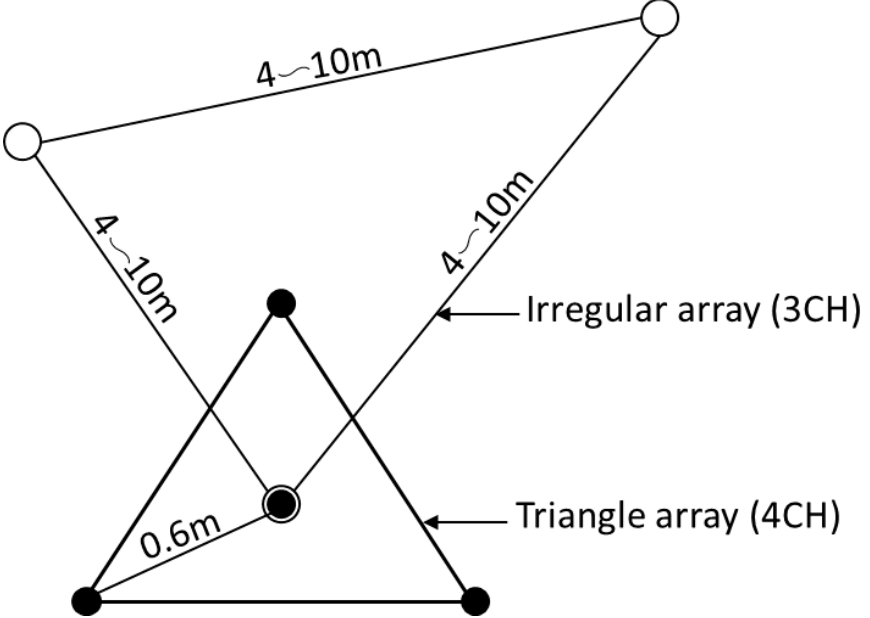
Figure 4. Conceptual diagram of the miniature and irregular seismic arrays modified after [60]. Circles represent seismometers.